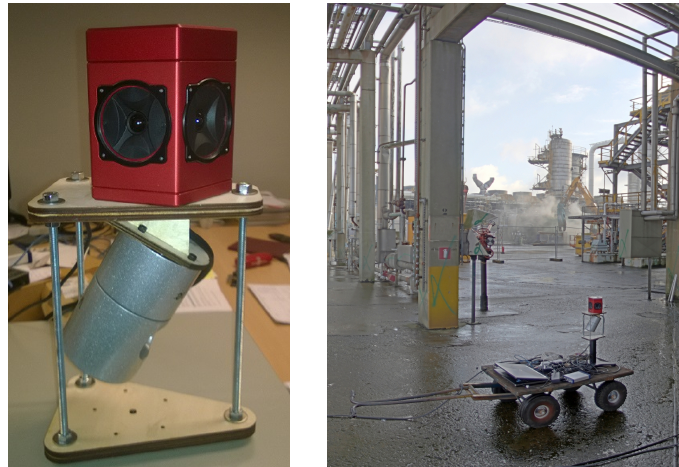
Figure 1. Two pictures of our mobile acquisition platform Vellady mounted on a kitchen cart ( right ) and close-up ( left ). The platform consists of a Ladybug panoramic camera (mounted at the top) and a Velodyne HDL32-e LiDAR scanner (mounted at the bottom).